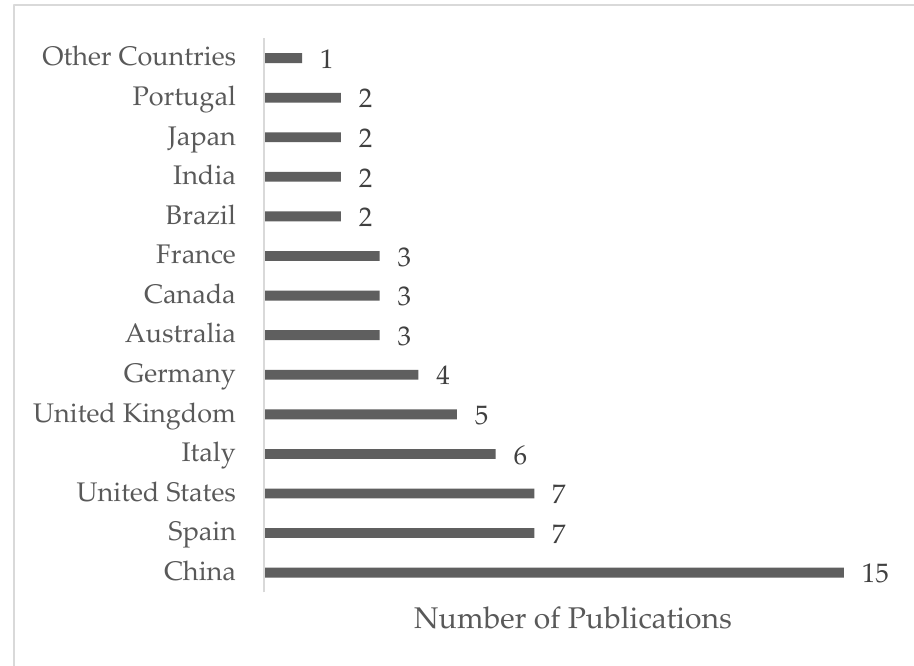
Figure 5. Country’s contribution to publications (from 2017 to February 2022).